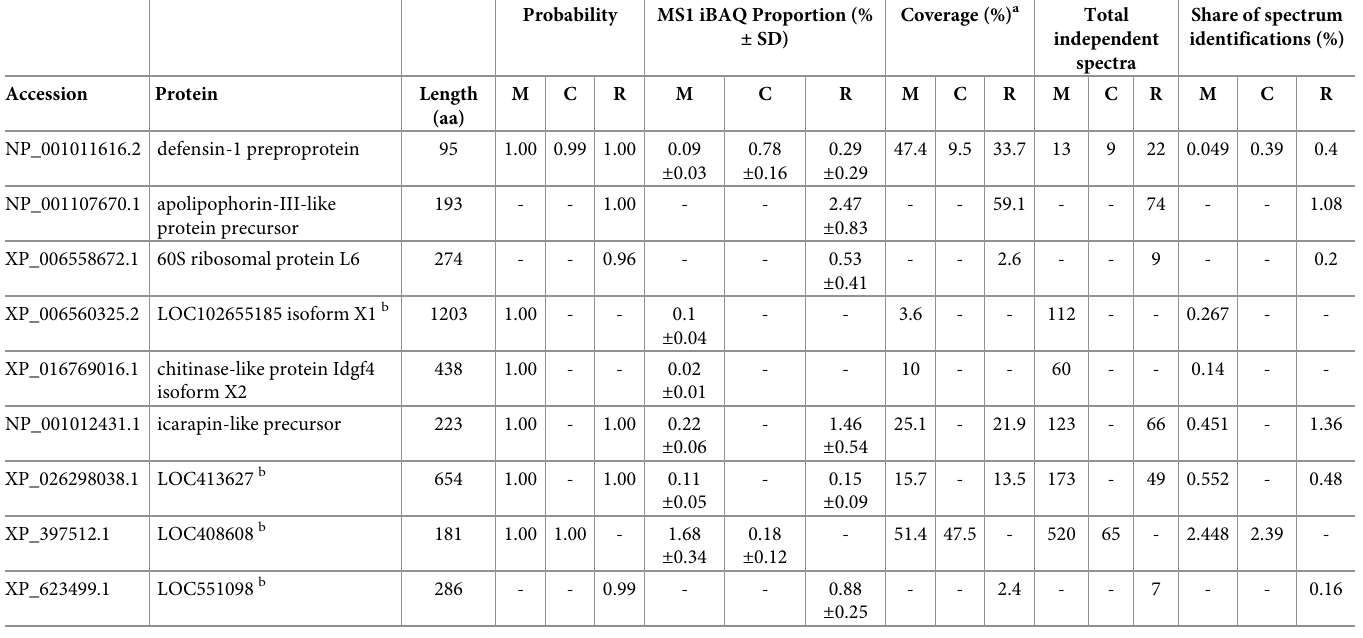
M, m ā nuka sample group; C, clover sample group; R, royal jelly sample group. a Signal sequences of secreted proteins were not excluded from analyses. b Uncharacterised